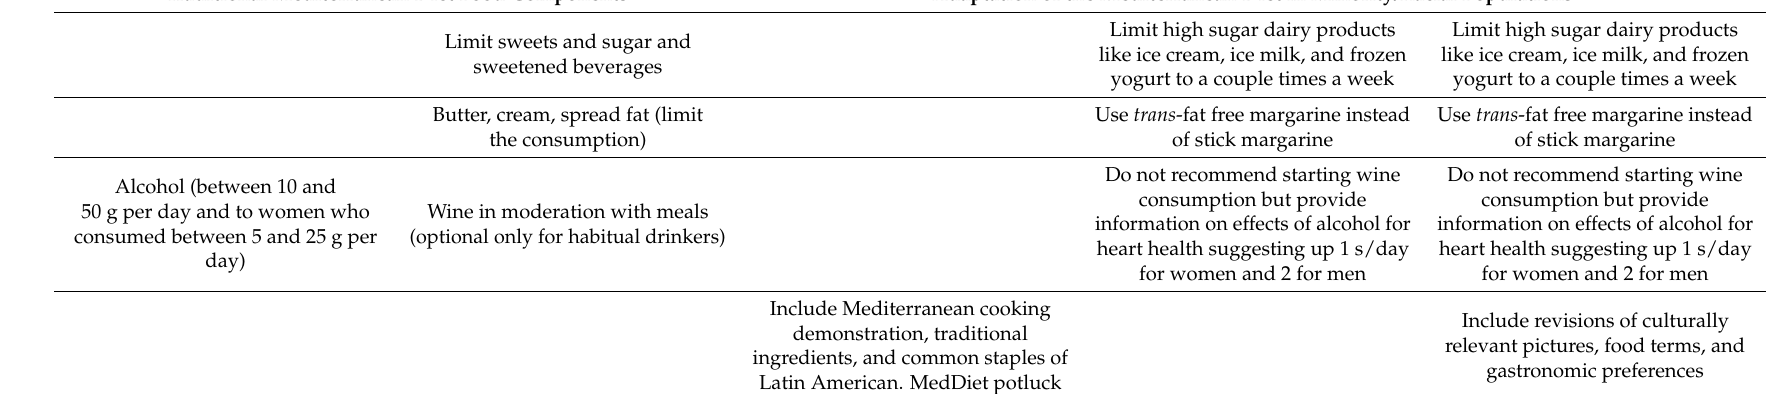
Limit high sugar dairy products like ice cream, ice milk, and frozen yogurt to a couple times a week Use trans -fat free margarine instead of stick margarine Do not recommend starting wine consumption but provide information on effects of alcohol for heart health suggesting up 1 s/day for women and 2 for men